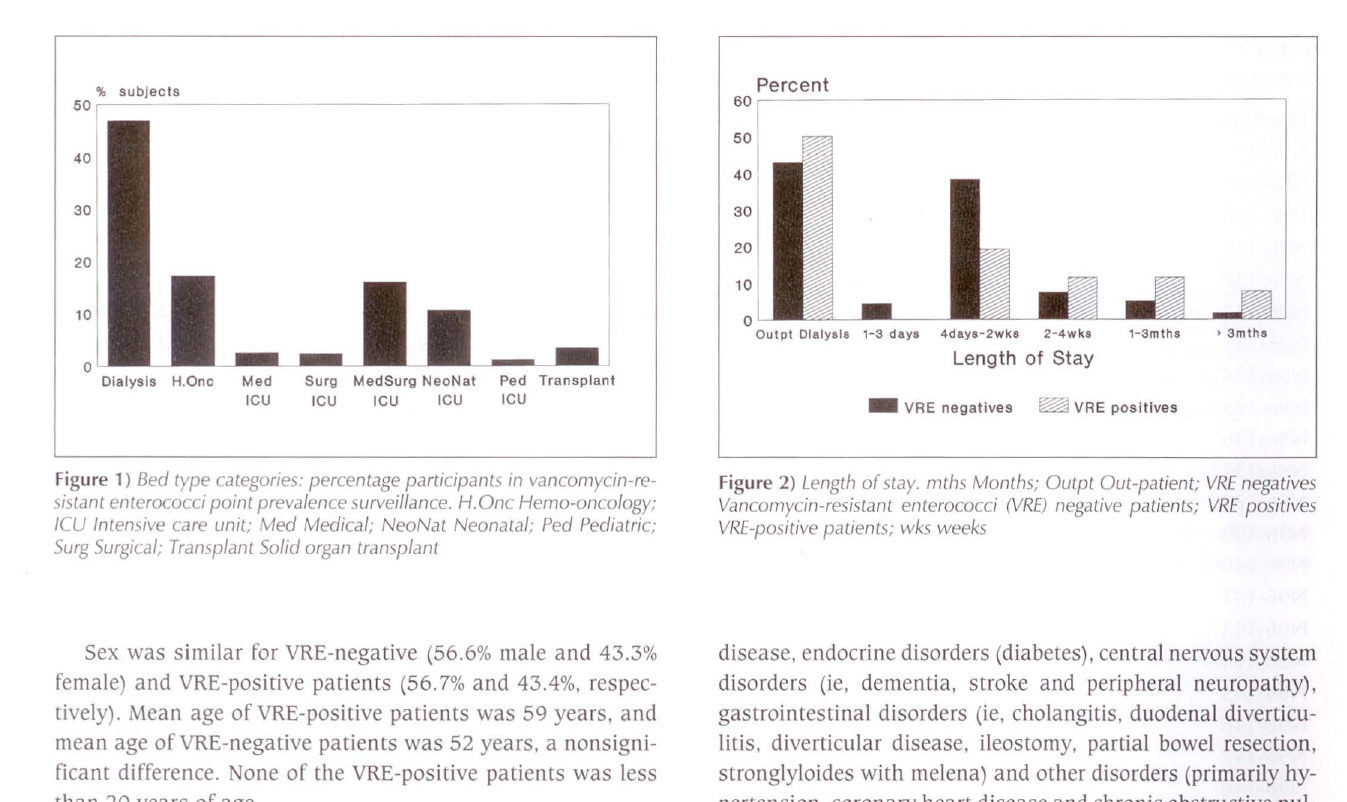
Figure 1) Bed type categories: percentage participants in vancomycin-re sistant enterococci point prevalence surveillance. H. One Hemo-oncology;